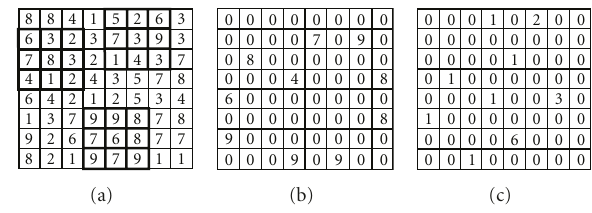
Figure 1: (a) A sample 8 × 8 data matrix; (b) local maxima map obtained from (a); and (c) local minima map obtained from (a).